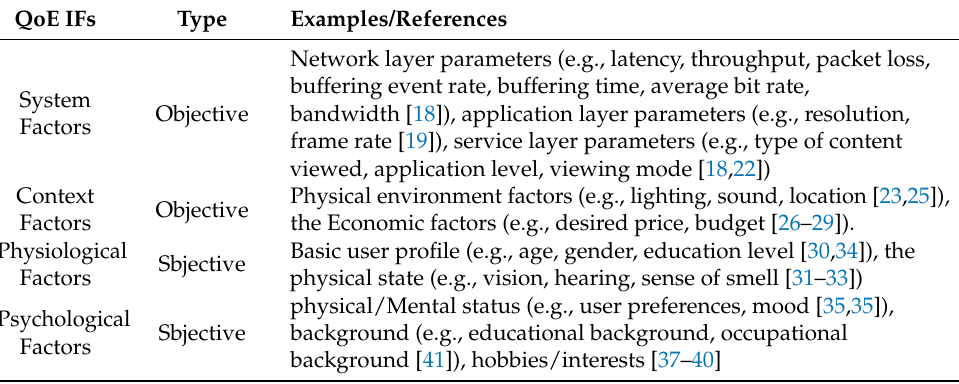
Table 1. The influencing factors of QoE.